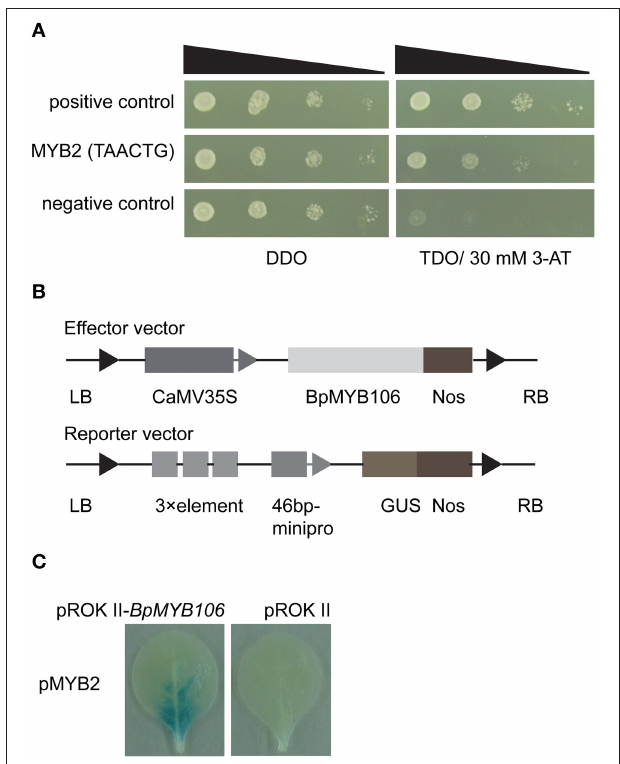
FIGURE 9 | Analyses of MYB-binding site of BpMYB106. (A) Analysis of the binding of BpMYB106 to the MYB2 by yeast one-hybrid (Y1H) study. Yeast cells were grown on selective dropout media: SD/-Trp-Leu/-His (TDO) with 30mM 3-amino-1, 2, 4-triazole (3-AT). Positive control: pHIS2-p53 co-transformed with pGADT7-Rec2 vector that encodes p53 fused with GAL4 AD; negative control: pHIS2-p53 co-transformed with pGADT7-Rec2-BpMYB106. (B) Diagram of the reporter and effector vectors used in β -glucuronidase (GUS) activity analysis. (C) Analysis of the interaction between MYB2 element and BpMYB106 in tobacco leaves using GUS staining, respectively. All assays were repeated three times.